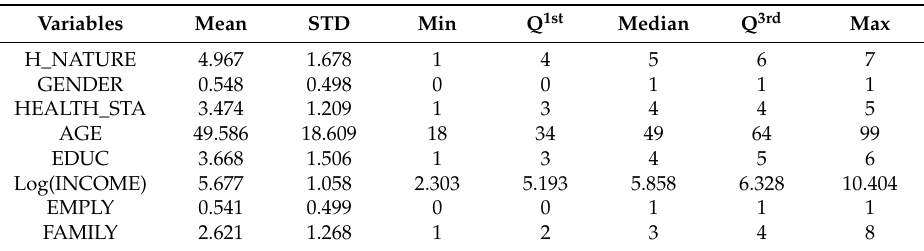
Table 2. Descriptive statistics of socio-personal